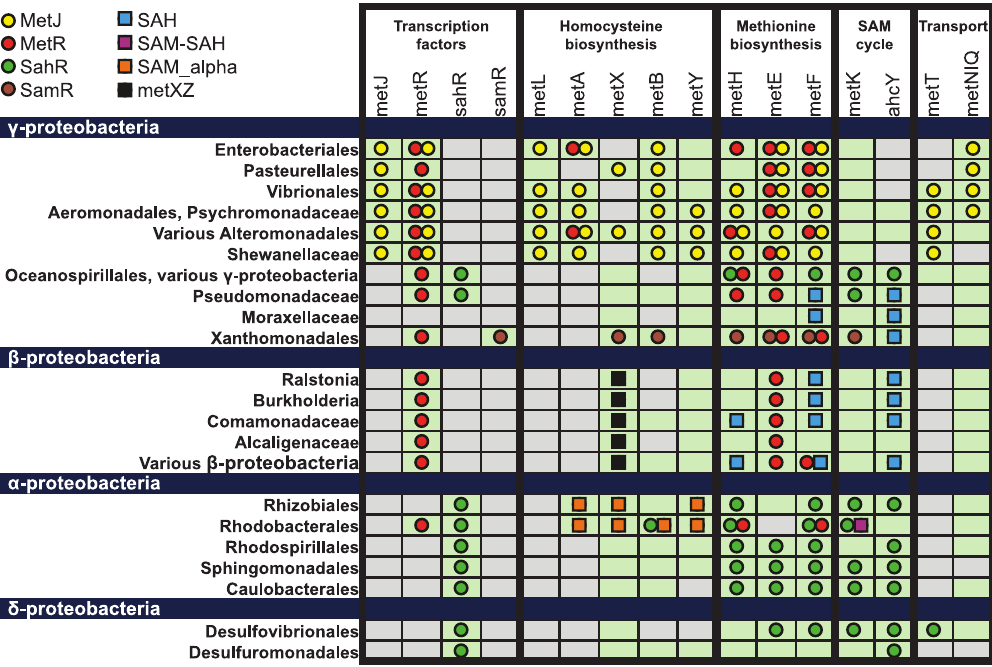
Figure 7. Distribution of regulatory interactions for core members of methionine regulons in Proteobacteria. The presence or absence of gene orthologs in at least one studied genome in a taxonomic group is shown by light green or gray background, respectively. Regulation of at least one gene ortholog within each taxonomic group is shown by colored circles and squares as in Figure 1.